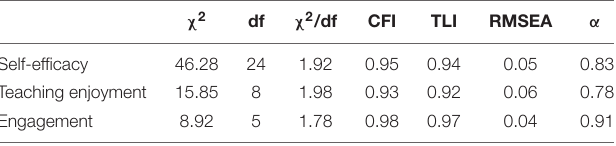
TABLE 1 | Measurement model of the latent constructs.